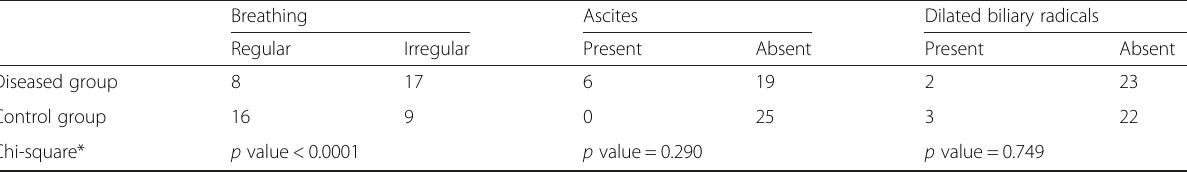
Table 2 Distribution of image quality score items among the studied groups Breathing